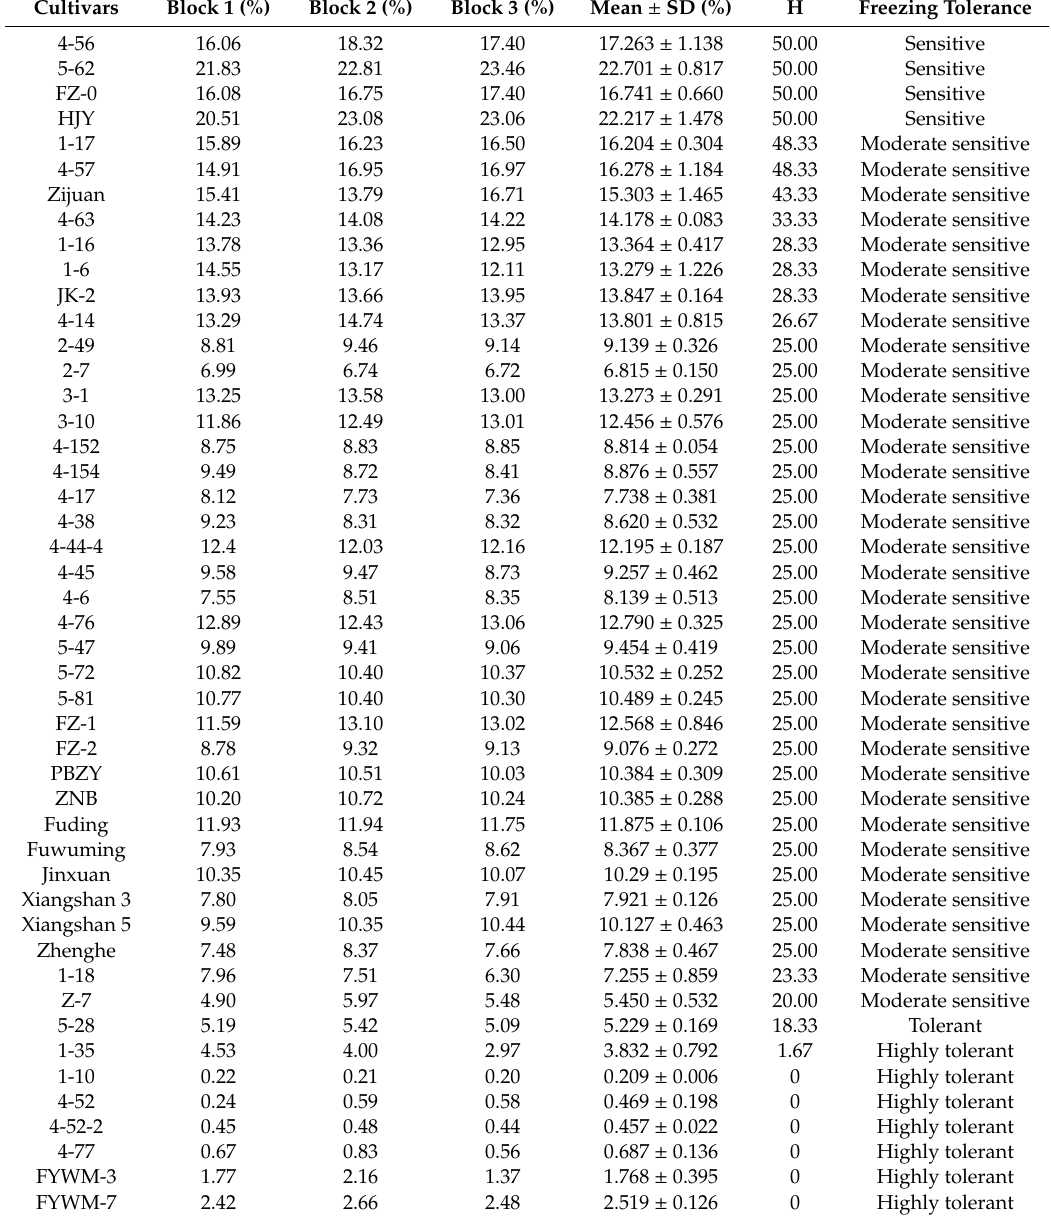
Table 1. Percentage of freezing-induced injured leaves of various cultivars 1